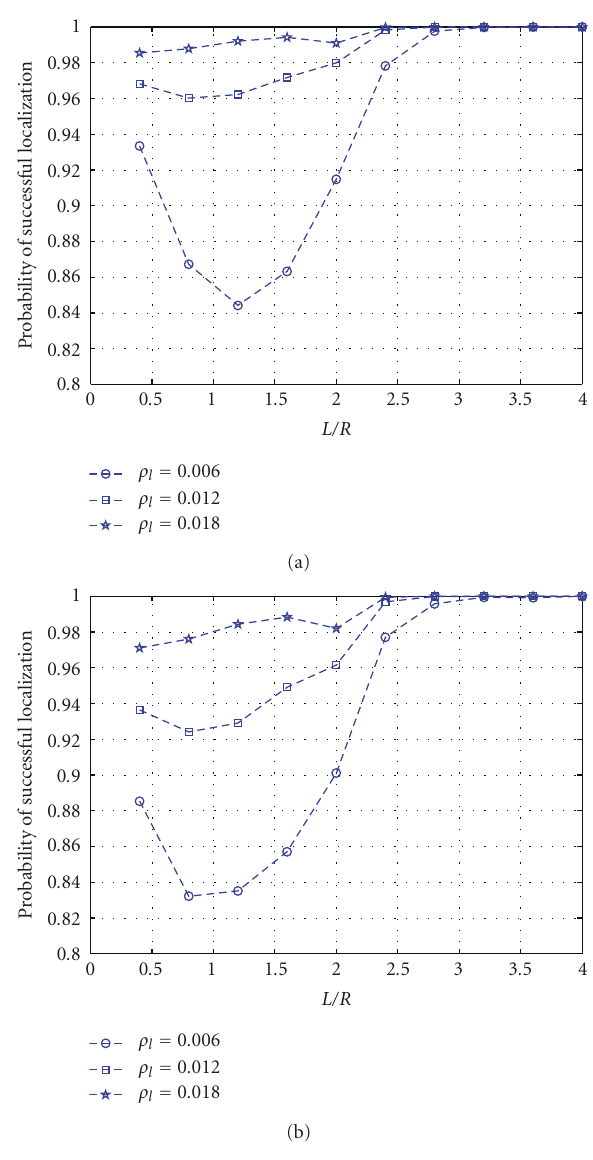
Figure 6: Performance evaluation: (a) the e ff ect of ρ l on basic TSCD scheme; (b) the e ff ect of ρ l on enhanced TSCD